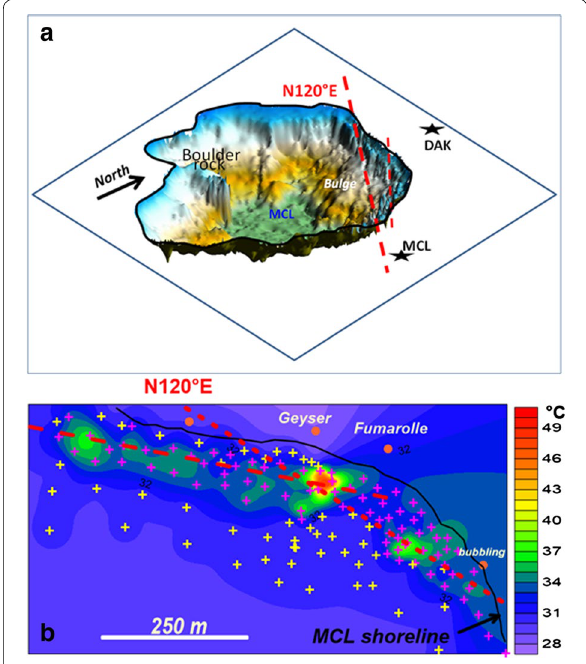
Fig. 2 a Bathymetry of Main Crater Lake ( MCL ); Red axis corresponds to the main submarine fissure axis (N120°E, heavy dashed line) along which degassing and heat fluxes are predominant. A secondary fissure is shown as a thin-dashed red line. b Thermal anomalies at the bottom of MCL recognized in December 2009 (pink crosses) and March 2010 (yellow crosses). Red dashed lines are fissures depicted in